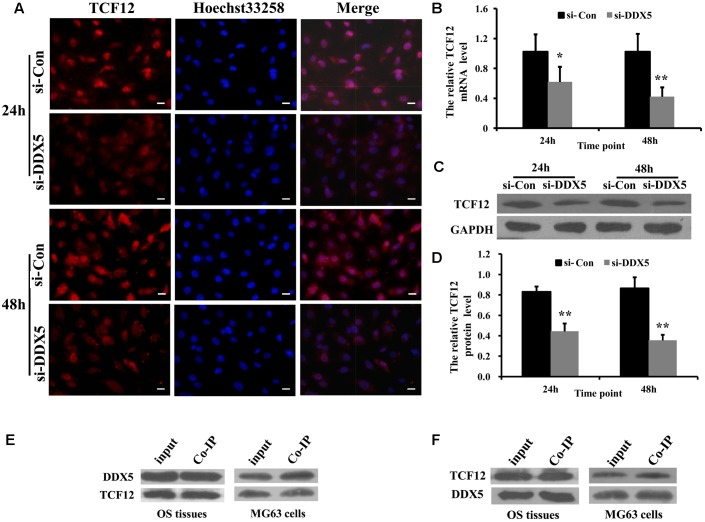
Knockdown of DDX5 downregulated the expression of TCF12 in MG63 cells and DDX5 interacted with TCF12 detected by Co-immunoprecipitation. (A) Expression of TCF12 was detected by immunofluorescence at 24 and 48 h after transfection with DDX5 siRNA (si-DDX5) or the negative control (si-Con), bar = 20 μm. (B) Data represent means ± SD of the relative TCF12 mRNA levels detected by qRT-PCR at 24 and 48 h after transfection with si-DDX5 or si-Con. (C) Western blot showed the expression of TCF12 in the MG63 cells at 24 and 48 h after transfection with si-DDX5 or si-Con. (D) Bar chart showed the relative TCF12 protein levels (n = 4), ∗P < 0.05, ∗∗P < 0.01 vs. si-Con. (E) Co-immunoprecipitation of DDX5 in clinical OS samples and OS MG63 cells indicated DDX5 interacted with TCF12. (F) Co-immunoprecipitation of TCF12 in clinical OS samples and OS MG63 cells indicated TCF12 interacted with DDX5.